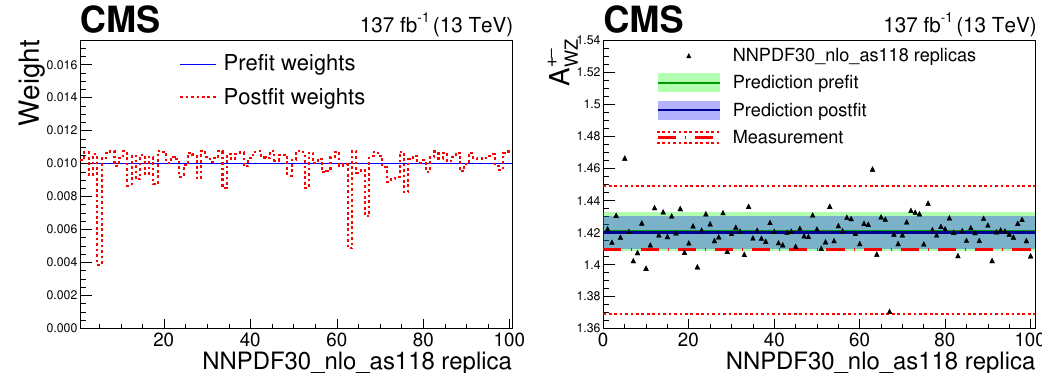
Figure 8 . (Left) Weights associated with each PDF replica in the NNPDF30_nlo_as0118 set before (blue) and after (red) the Bayesian reweighting technique is applied based on the charge asymmetry ratio measurement. (Right) Predictions and updated predictions (using the posterior weights) of the charge asymmetry ratio in WZ production using the nominal powheg sample with the NNPDF30_nlo_as0118 PDF set. The central green line gives the nominal predicted values, the shaded bands include the total uncertainty of the PDF set computed using the sample variance of the predictions obtained with each replica, and the triangles are the individual replica predictions. The red dashed and dotted lines are the measured value and uncertainties of the analysis. The blue bands show the predicted central value and uncertainties obtained after the Bayesian reweighting